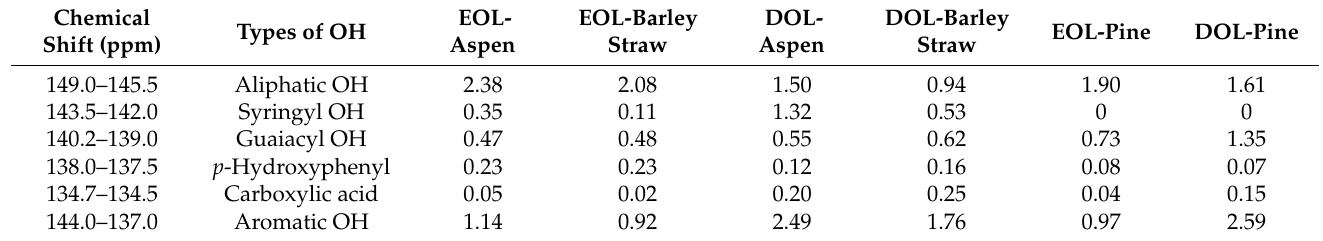
Table 2. Six organosolv lignin samples and their hydroxyl contents (mmol OH/g of dried lignin) that were determined by 31 P NMR according to their integration for specific type of OH